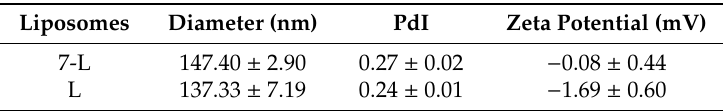
Table 3. Liposome